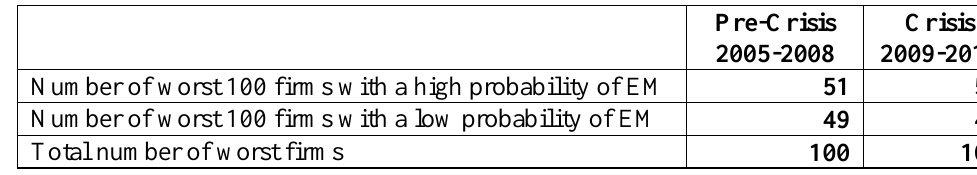
Table 6: Manipulation Scores on Worst 100 by